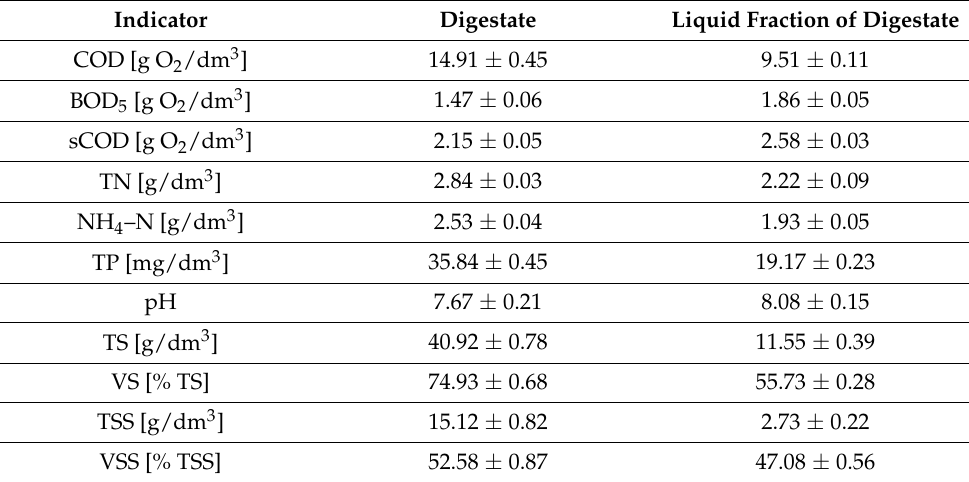
Table 1. Characteristics of